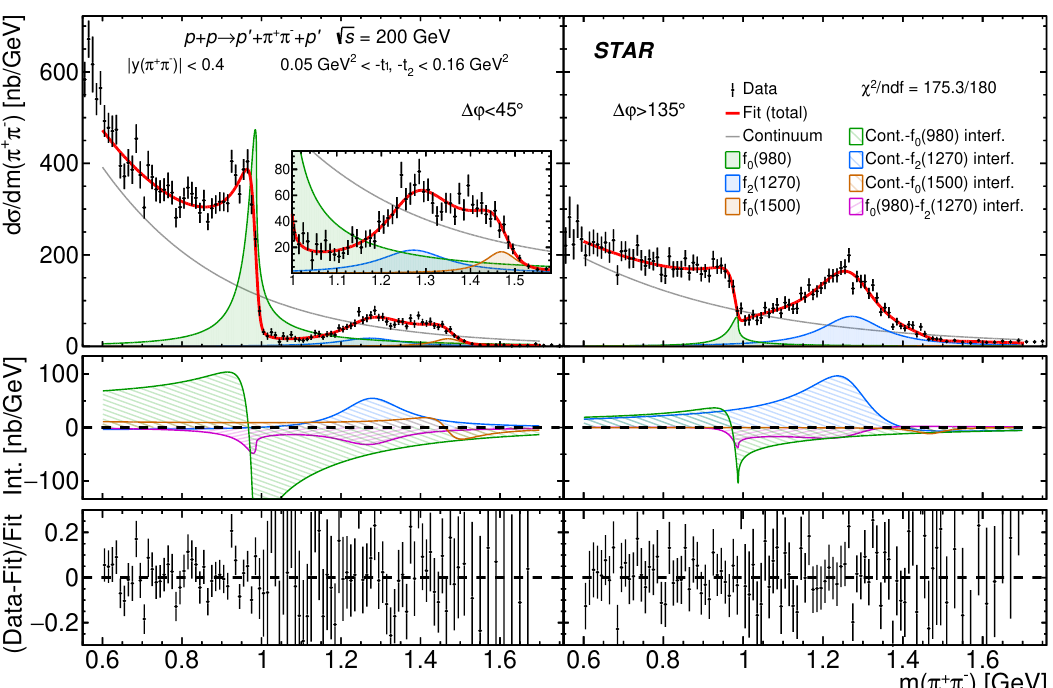
Figure 4: Differential cross section d σ/ dm ( π + π − ) extrapolated from the fidu- cial region to the Lorentz-invariant phase space given by the central-state rapidity, | y ( π + π − ) | < 0.4, and squared four-momentum transferred in forward proton ver- < 0.16GeV 2 [ 5 ] . The left and right panels show the tices, 0.05GeV 2 < − t , − t 1 2 cross sections for ∆ ϕ < 45 ◦ and ∆ ϕ > 135 ◦ , respectively. The data are shown as black points with error bars representing statistical uncertainties. The result of the fit is drawn with a solid red line. The squared amplitudes for the continuum and reso- nance production are drawn with lines of different colors, as explained in the legend. The most significant interference terms are plotted in the middle panels, while the relative differences between each data point and the fitted model are shown in the bottom